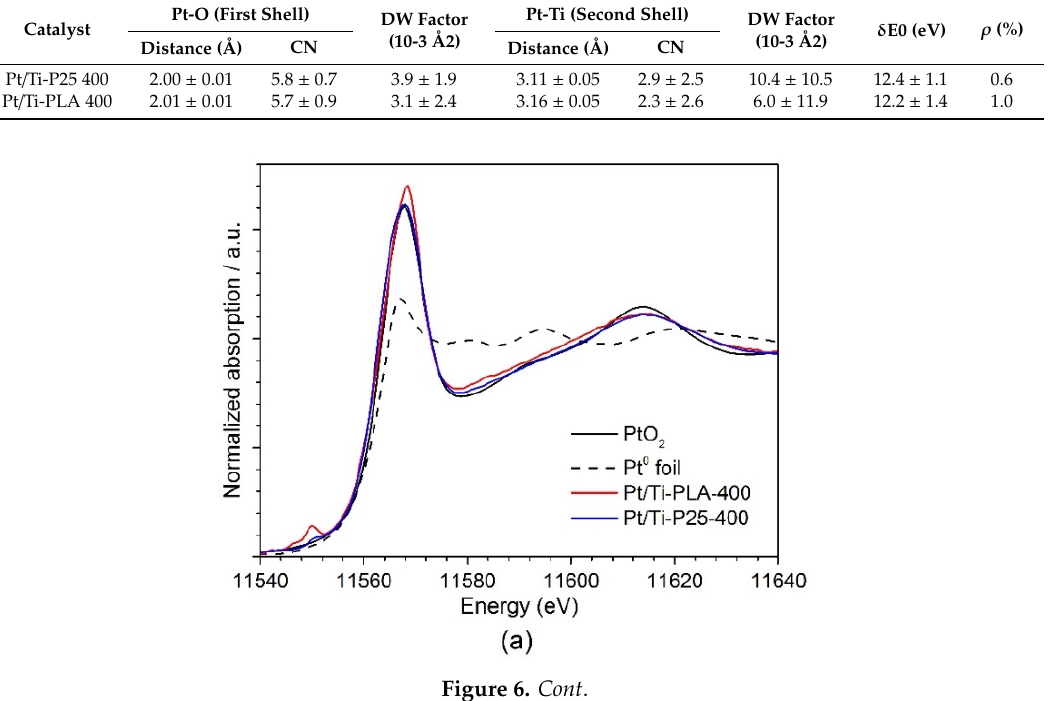
Table 2. Results of extended X-ray absorption fine structure (EXAFS) fitting to a structural model containing O backscatterers (first shell) and Ti backscatterers (second shell) as nearest neighbors.